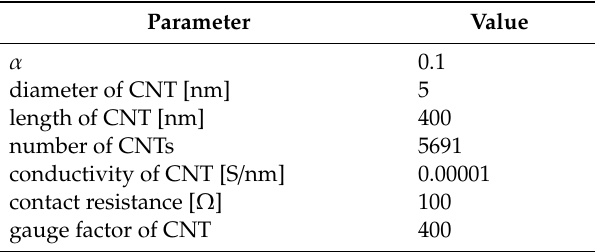
Table 2. Material parameters for 3D resistance network model.